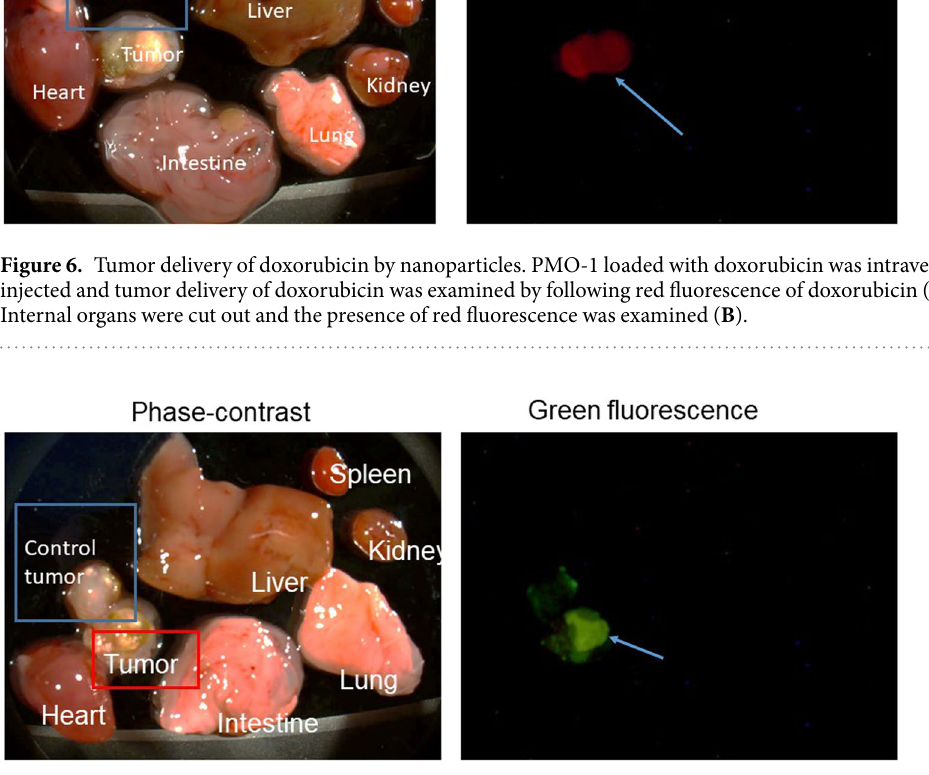
Figure 7. Tumor accumulation of PMO nanoparticles. FITC labeled PMO-2 were intravenously injected into eggs with A549 tumor. Three days later, tumor as well as various internal organs were isolated and